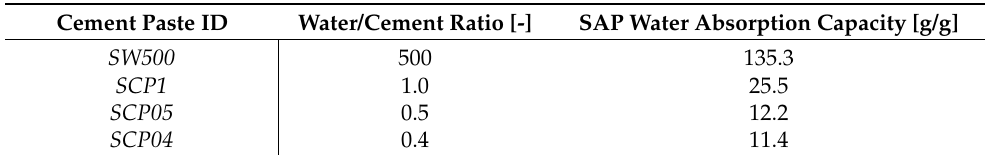
Table 4. The maximal water absorption capacity of SAP S in water absorption environments charac- terized by different water-to-cement ratios.